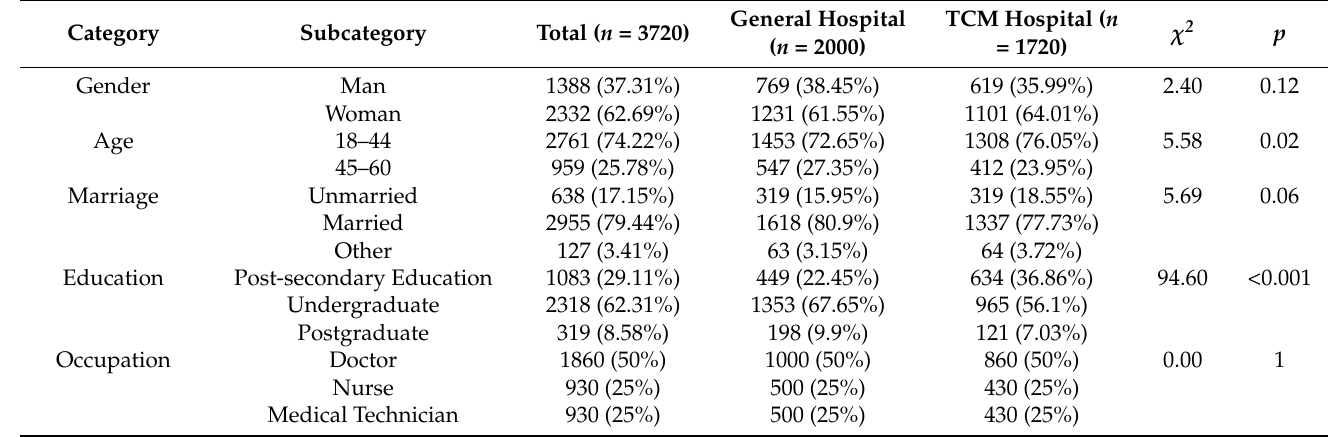
Table 1. Descriptive characteristics of medical staff by hospital category.